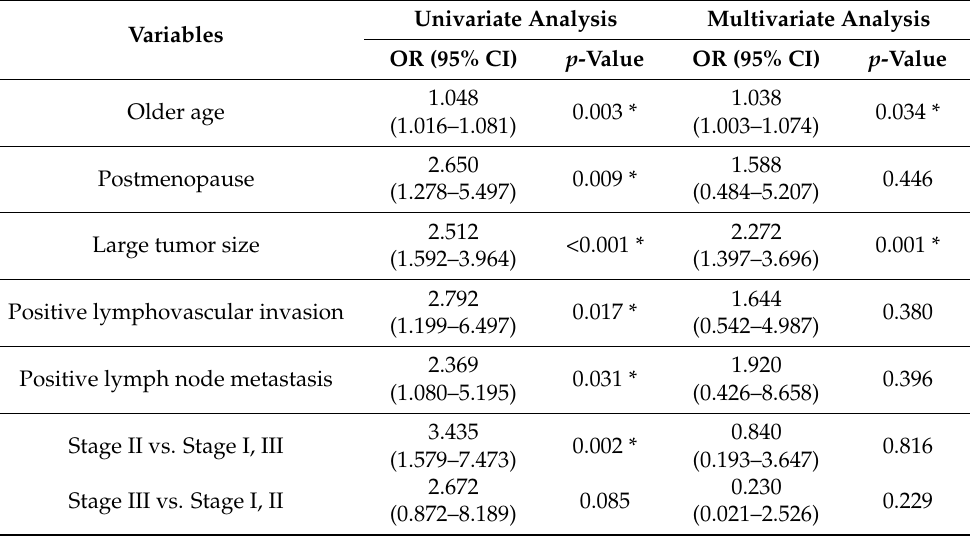
Figure 2. Association between ultrasound (US) elastography and fibrotic focus (FF) and patient outcomes in breast cancer. ( A ) Recurrence − free survival (RFS) according to US elastography, ( B ) overall survival (OS) according to US elastography, ( C ) RFS according to FF, ( D ) OS accord- ing to FF. Kaplan − Meier survival analysis with the log-rank test was used, and a p − value of <0.05 was considered statistically significant. Table 5. Univariate and multivariate analysis of association between fibrotic focus and clinicopatho- logical